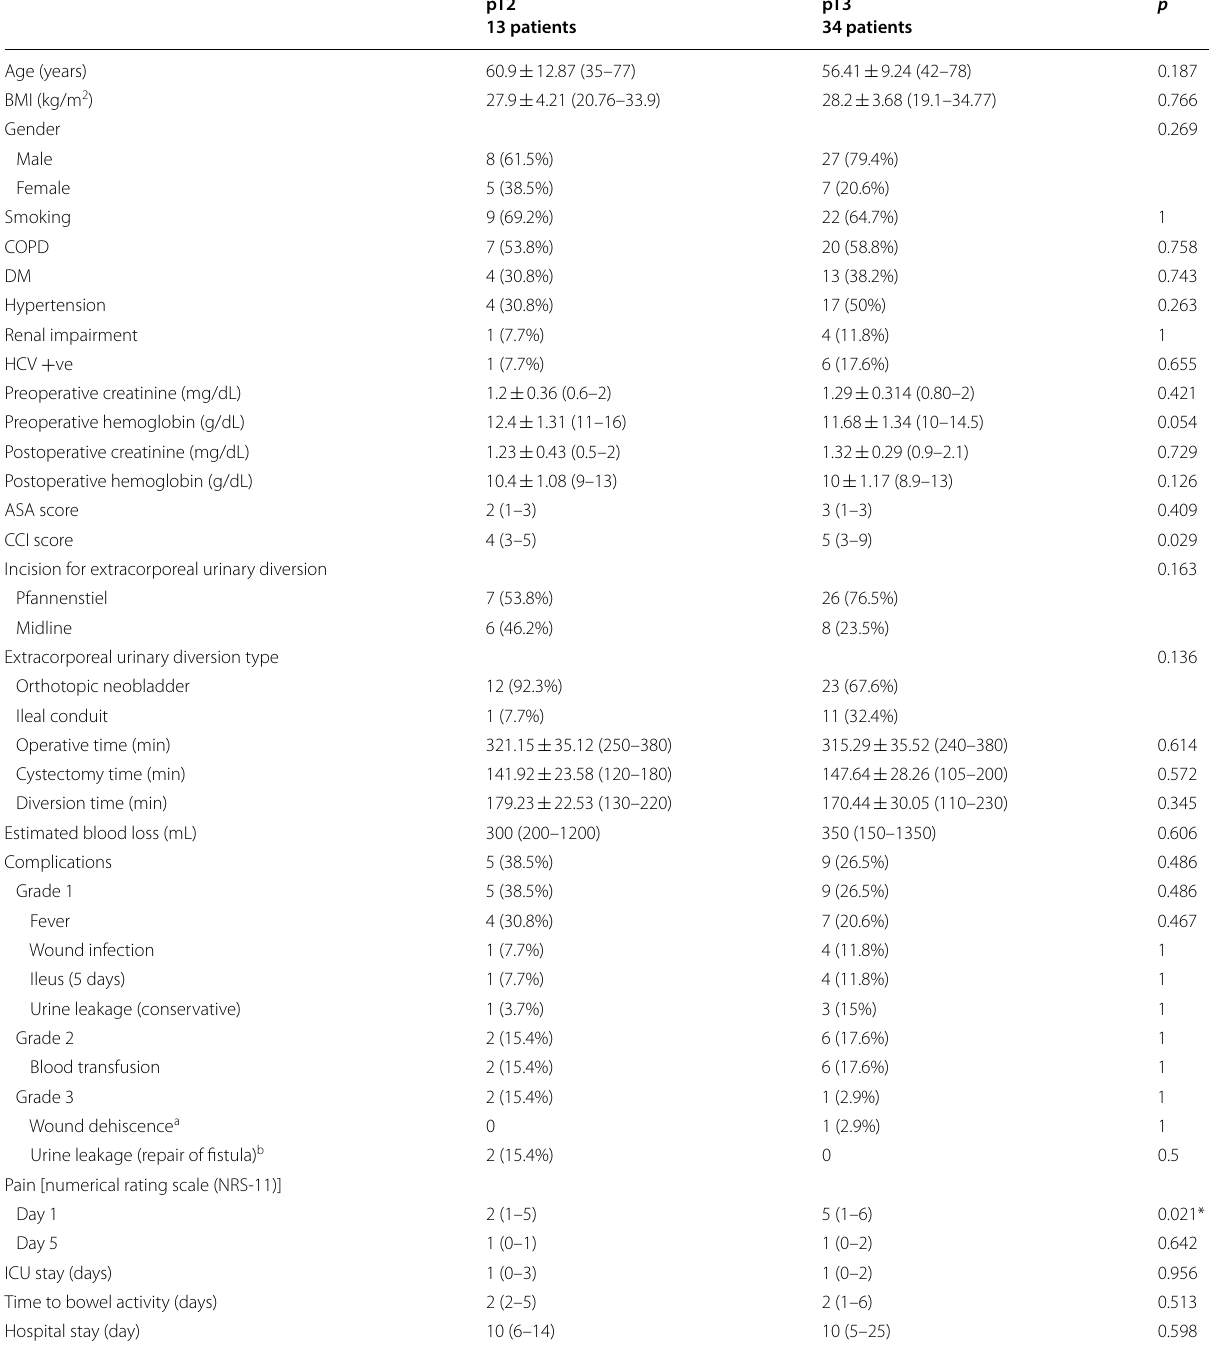
Table 3 Comparison of the two groups according to pathological